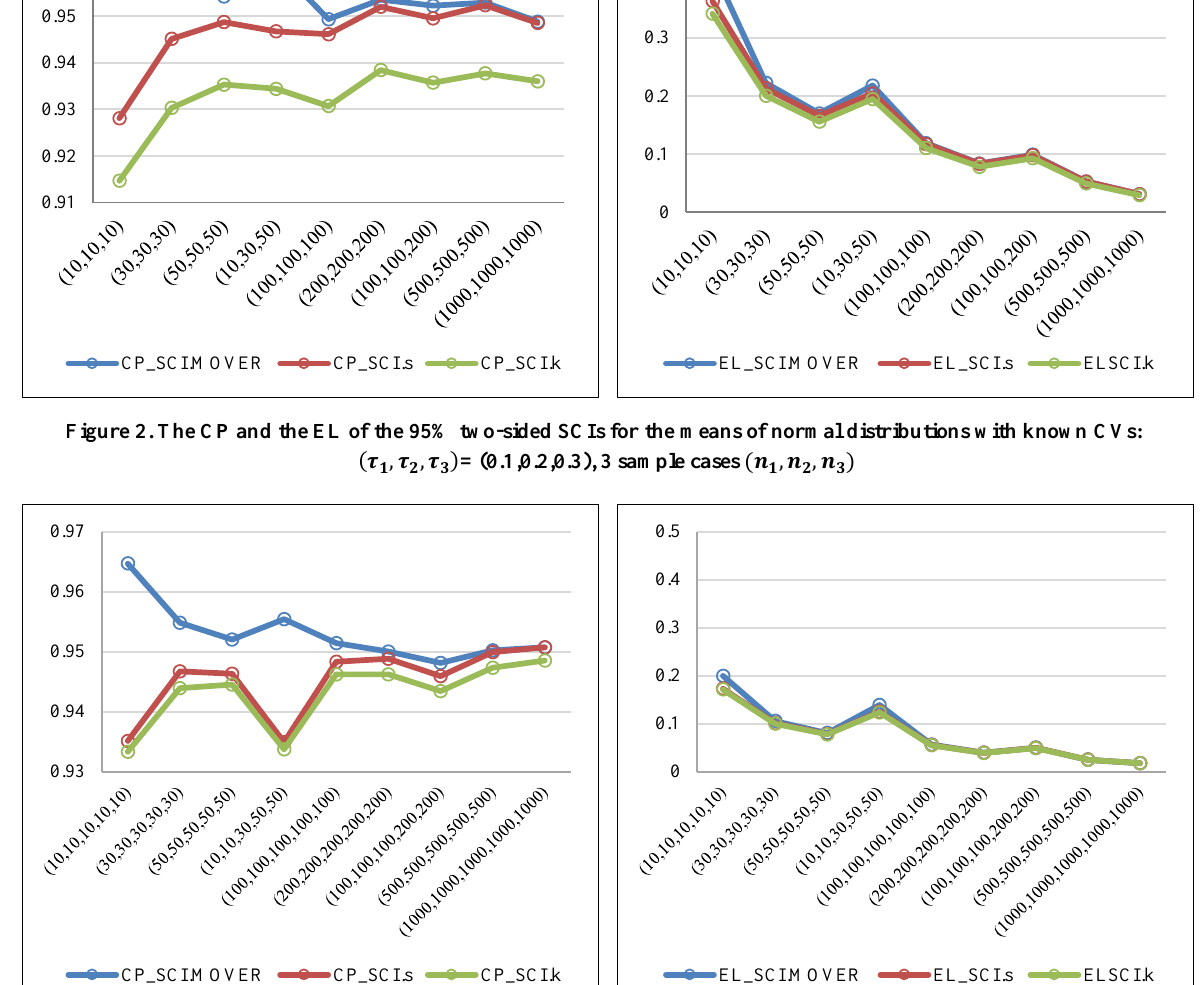
Figure 3. The CP and the EL of the 95% two-sided SCIs for the means of normal distributions with known CVs: (𝝉 ) = (0.1,0.1,0.1,0.1,0.1), 5 sample cases (𝒏 𝟏 , 𝝉 𝟐 , 𝝉 𝟑 , 𝝉 𝟒 , 𝝉 𝟓